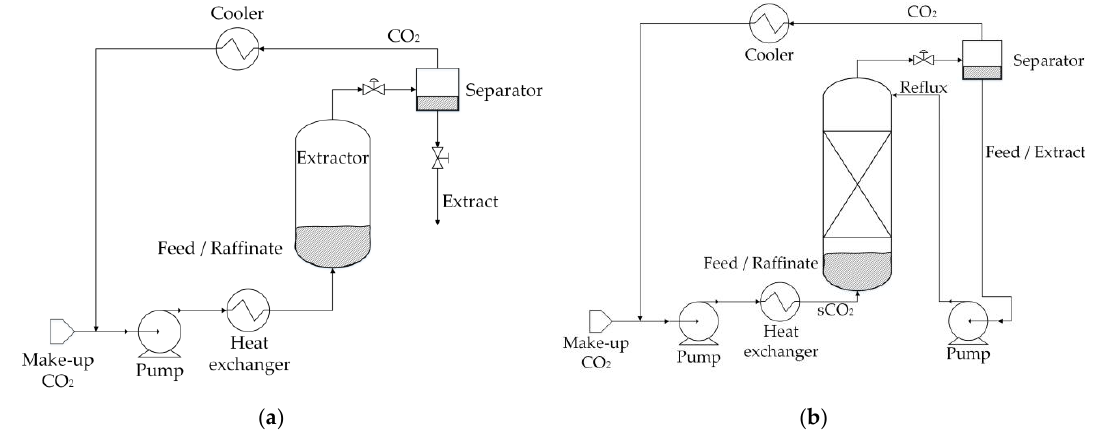
Figure 3. Flow diagram of semi-continuous extraction processes. ( a ) Single stage; ( b ) multi-stage.